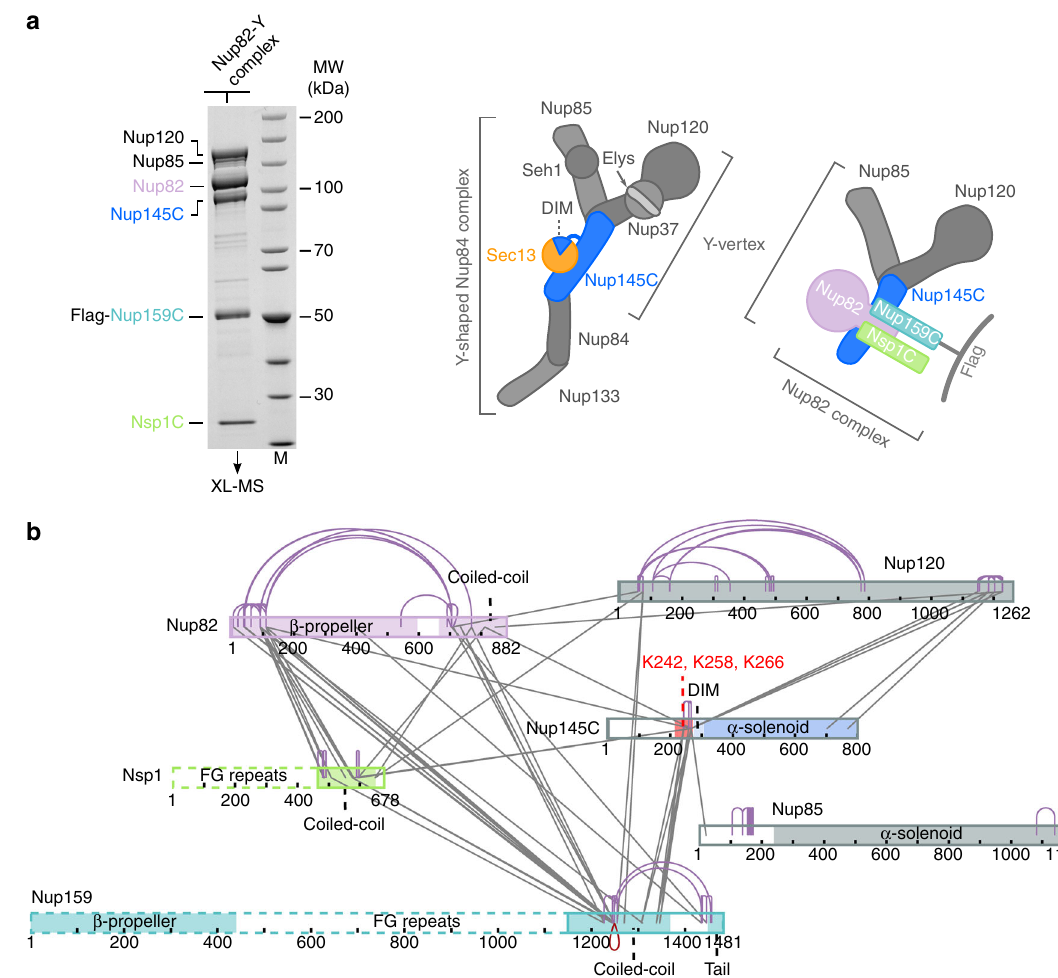
Fig. 1 XL-MS analysis of the Ct Nup82 complex with the central vertex of the Y-shaped Ct Nup84 complex. a In vitro reconstitution of the Ct Nup82 – Y complex ( Ct Nup82 – Nup159C – Nsp1C – Nup145C – Nup85 – Nup120). An immobilized Flag- Ct Nup159C – Nup82 – Nsp1C complex was incubated with the soluble Ct Nup145C – Nup85 – Nup120 complex (Y-vertex). Shown is the analysis of the Flag eluate by SDS-PAGE and coomassie staining. Ct Nup145C is highlighted in blue as it interacts directly with the Ct Nup82 complex 41 . M marker, MW molecular weight. An uncropped image of the gel is shown in Supplementary Fig. 4a. b Schematic representation of the Ct Nup82 – Y complex showing the crosslinks determined by mass spectrometry. Crosslinks are depicted as straight gray lines, intramolecular self-links as curved purple lines, and intermolecular self-links as dark red loops. DIM domain invasion motif. Additional data are shown in Supplementary Table 2 and Supplementary Data